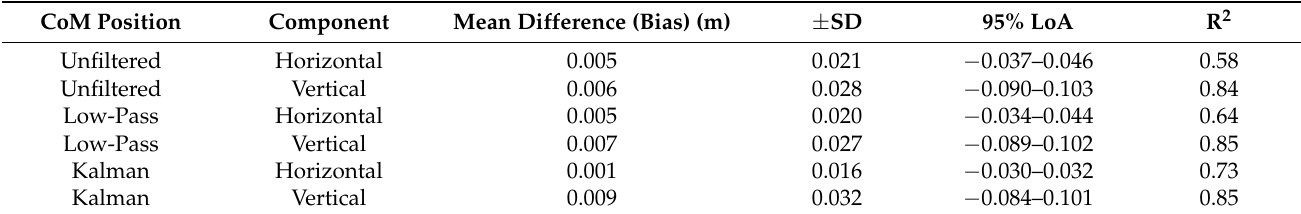
Table 1. Between system comparison of CoM position during sprinting.